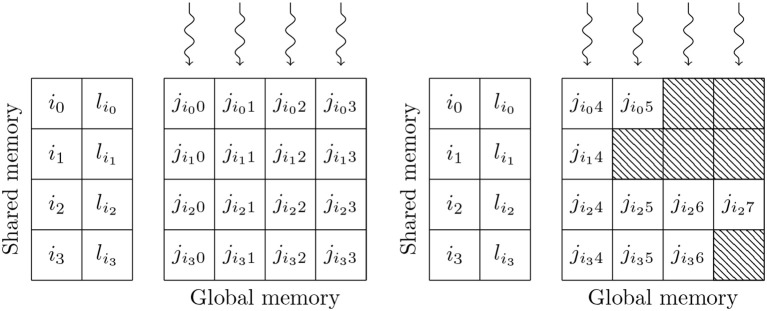
GPU parallelization of sparse synaptic matrix processing across two thread blocks each with 4 threads. i0, …, i3 contain the indices of presynaptic spikes. li0, …, li3 contain the lengths of the corresponding matrix rows. j contains the indices of the postsynaptic target neurons. Snaking lines indicate CUDA threads. Hatching indicates padding entries.